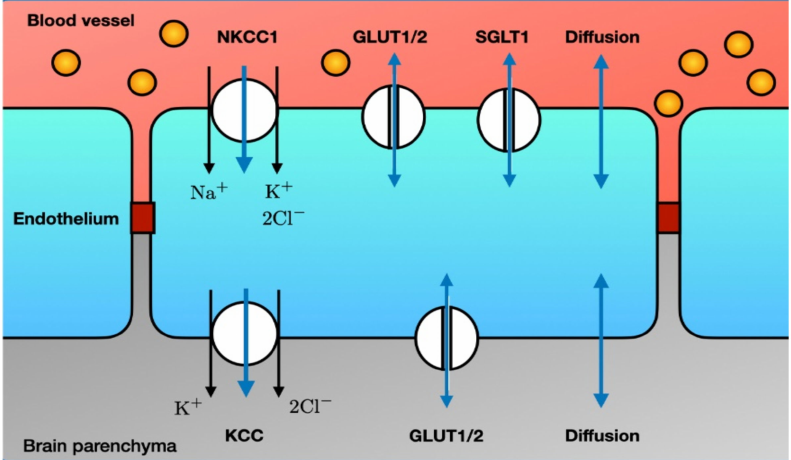
Figure 7. Major routes for influx of water through the blood brain barrier. Single-headed blue arrows denote water co-transport, while double-headed blue arrows denote passive water transport. Note the asymmetry in the various transporters between the luminal and abluminal side. Endothelial tight junctions (dark red) prevent leakage of macromolecules (e.g., albumin, yellow circles) from the capillary blood. The many other ion transporters and ion channels that do not transport water are not shown. Abbreviations: see text. Illustration adapted from